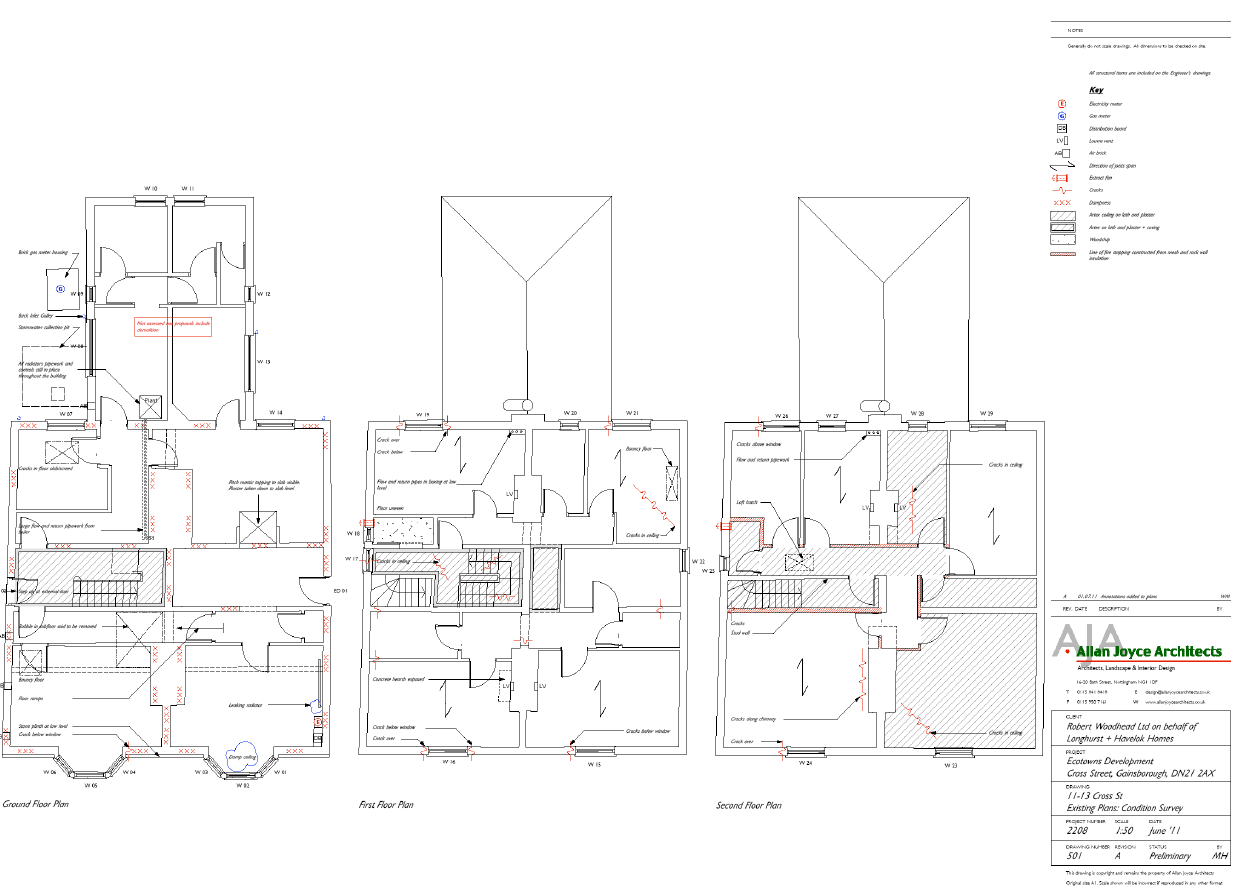
Figure 2. Floor plans before refurbishment (Drawings: Allan Joyce Architects